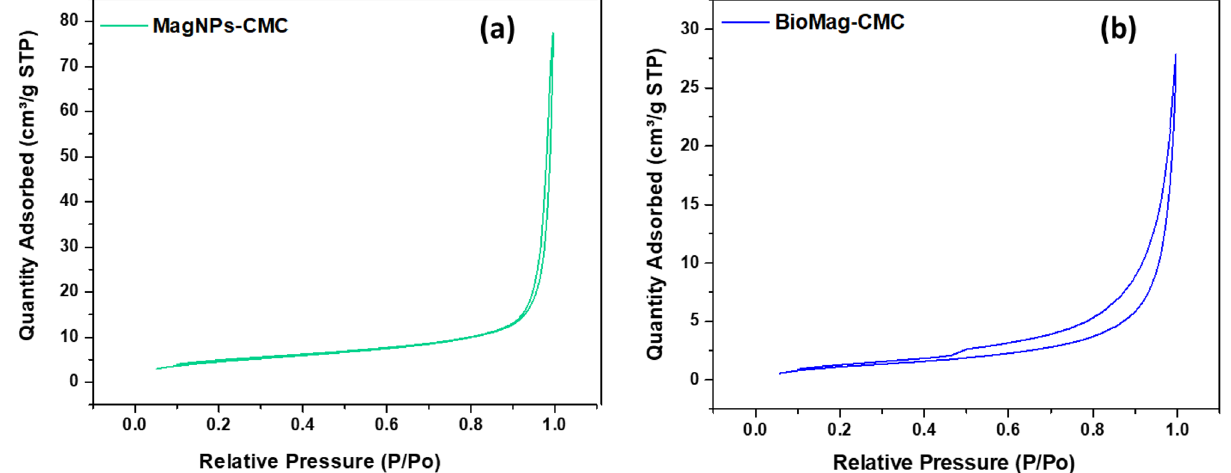
Figure 5. The nitrogen adsorption–desorption curves of ( a ) MagNPs-CMC, ( b )